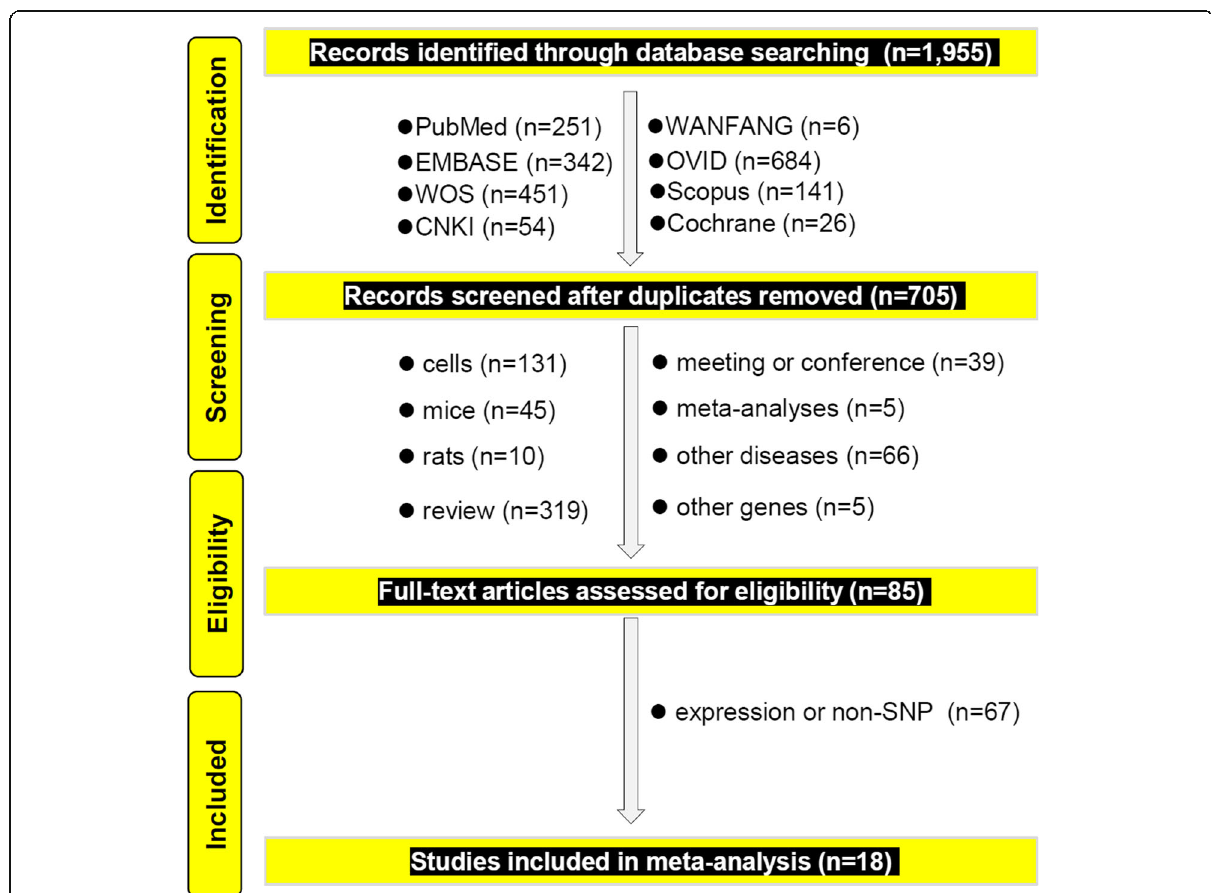
Fig. 1 The flow chart of the eligible case-control study